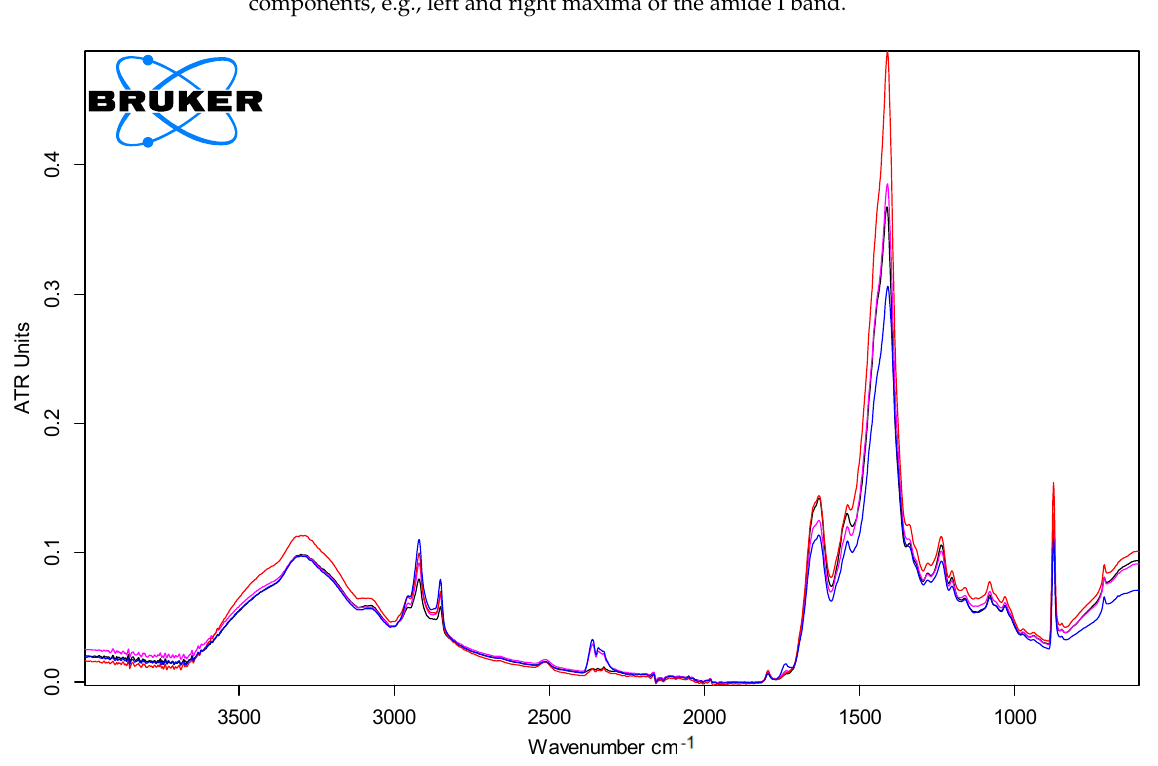
Figure 4. The ATR spectra for non-irradiated control batches from tail area (A–D); red, blue, and magenta curves depict samples near the backbone, and black curve depicts the sample farthest from the backbone.